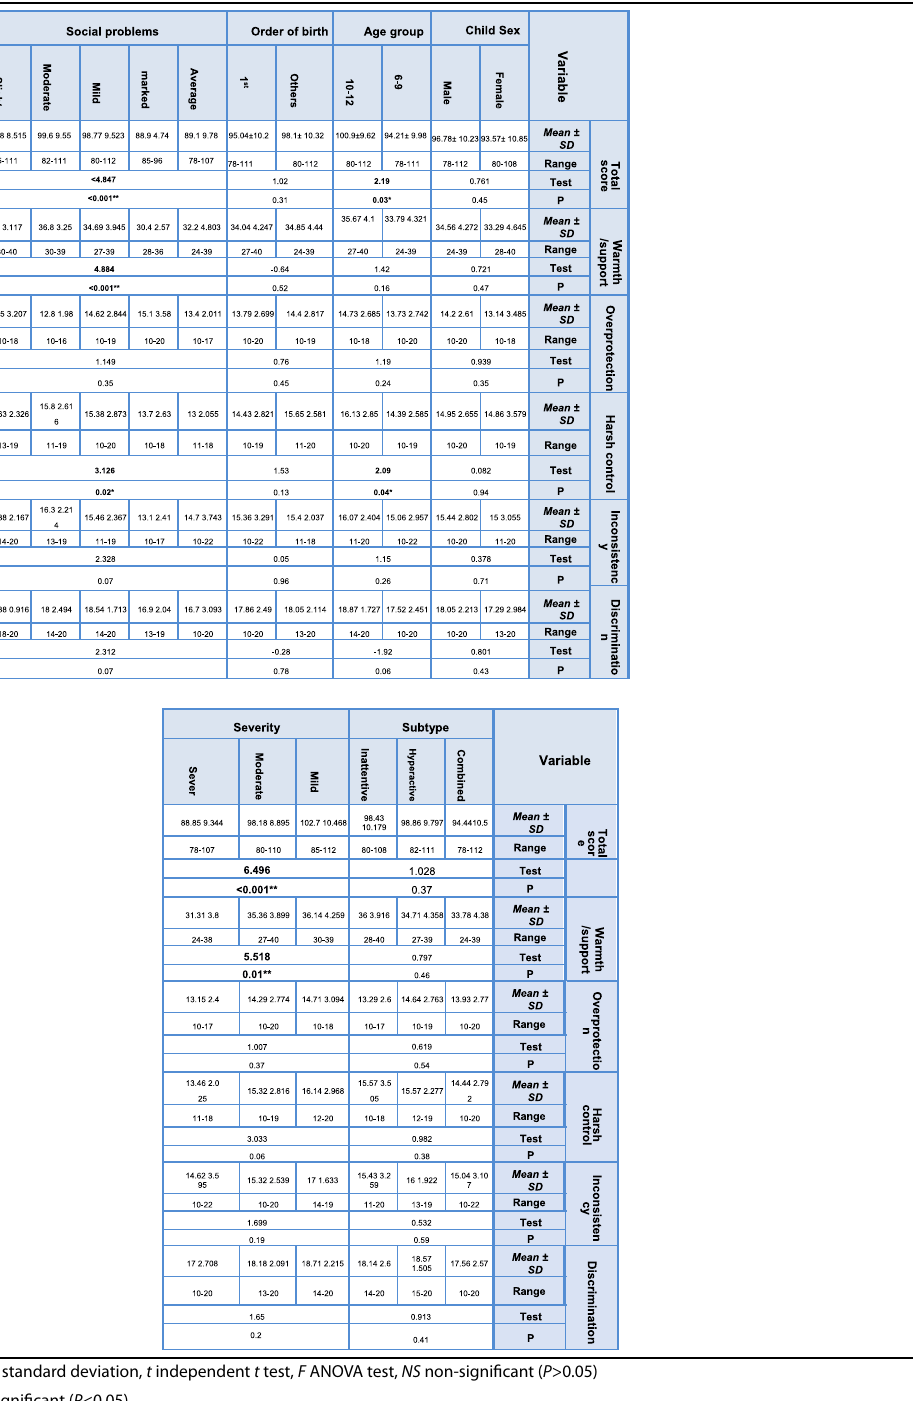
Table 3 Relationship between child characteristics and parenting attitudes of